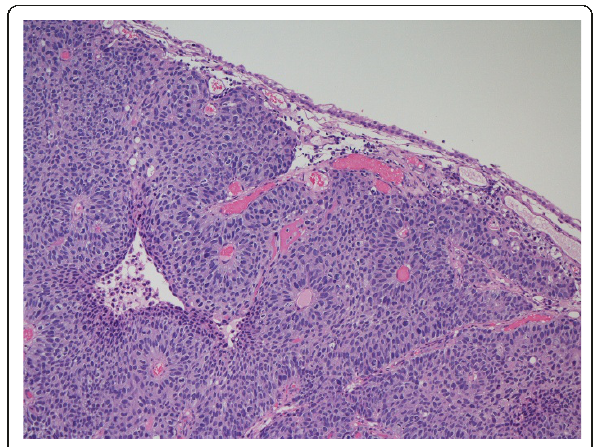
Figure 11 Urothelial carcinoma with endophytic growth pattern